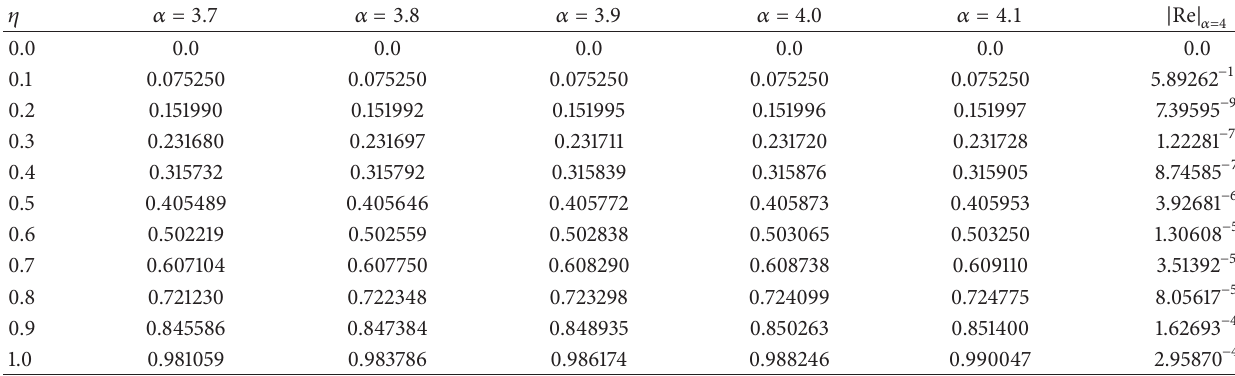
Table 5: Solutions for different values of 𝜂 and 𝛼 at 𝑅 = 0.3 and 𝛾 = 1 in case of slip boundary.